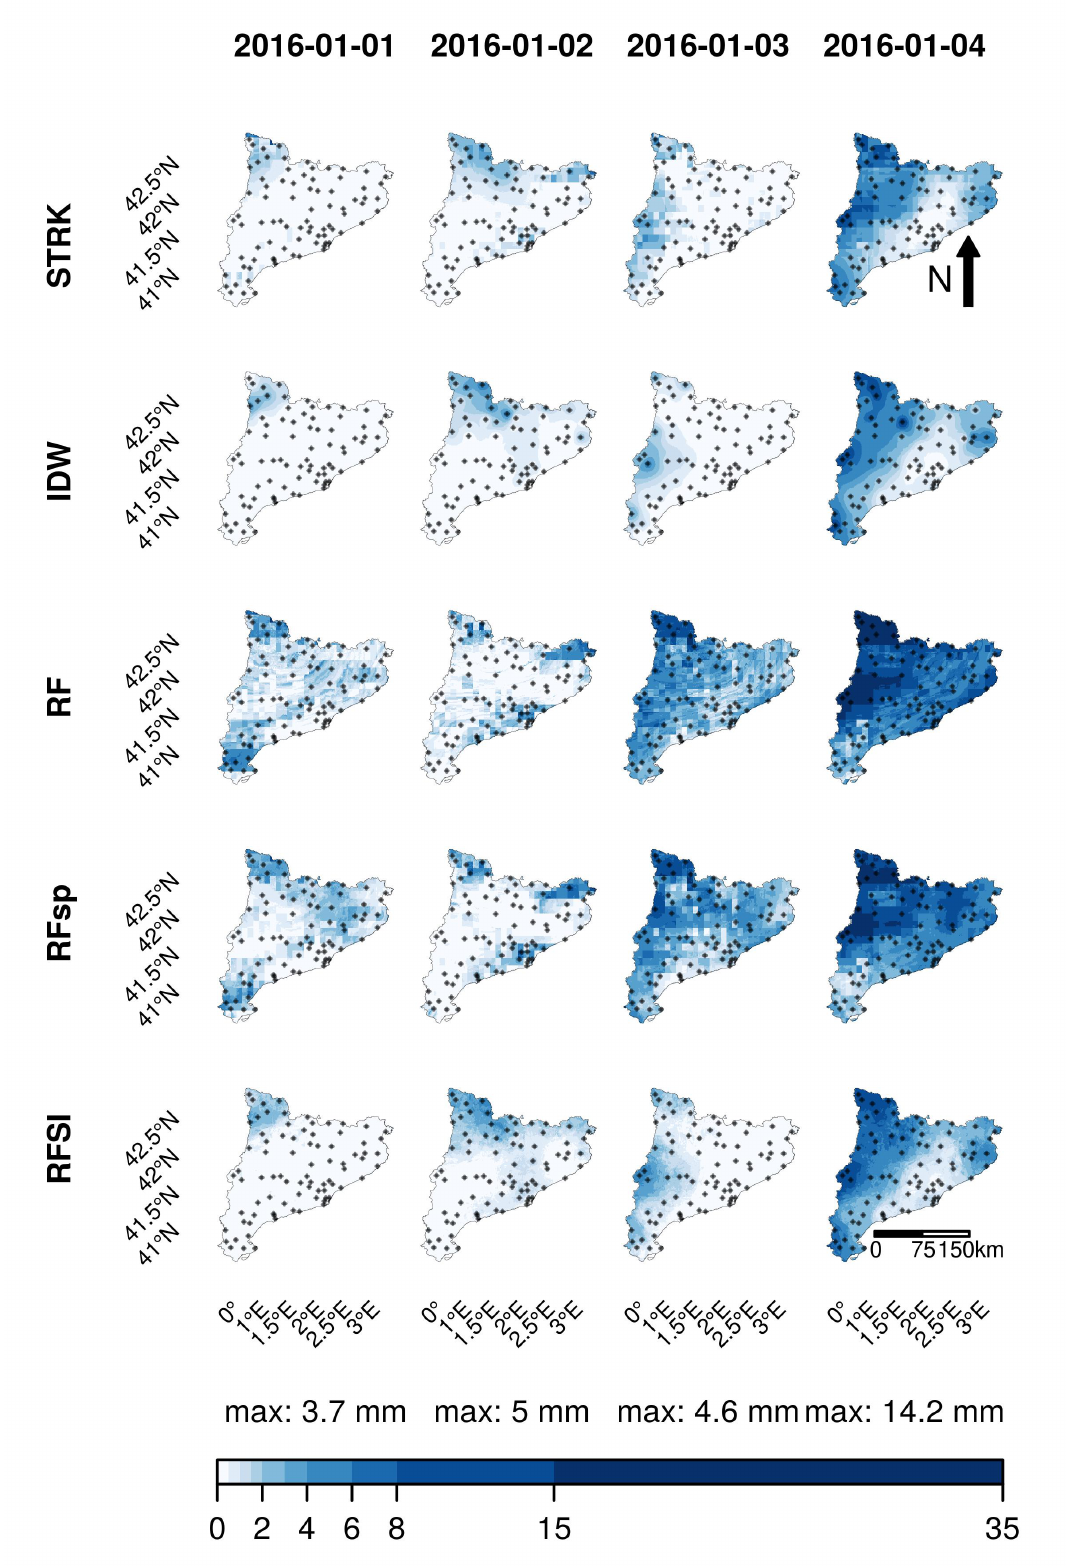
Figure 12. Prediction maps of daily precipitation (mm) for the five models, for 1–4 January 2016. The bottom row shows the maximum observed precipitation for each